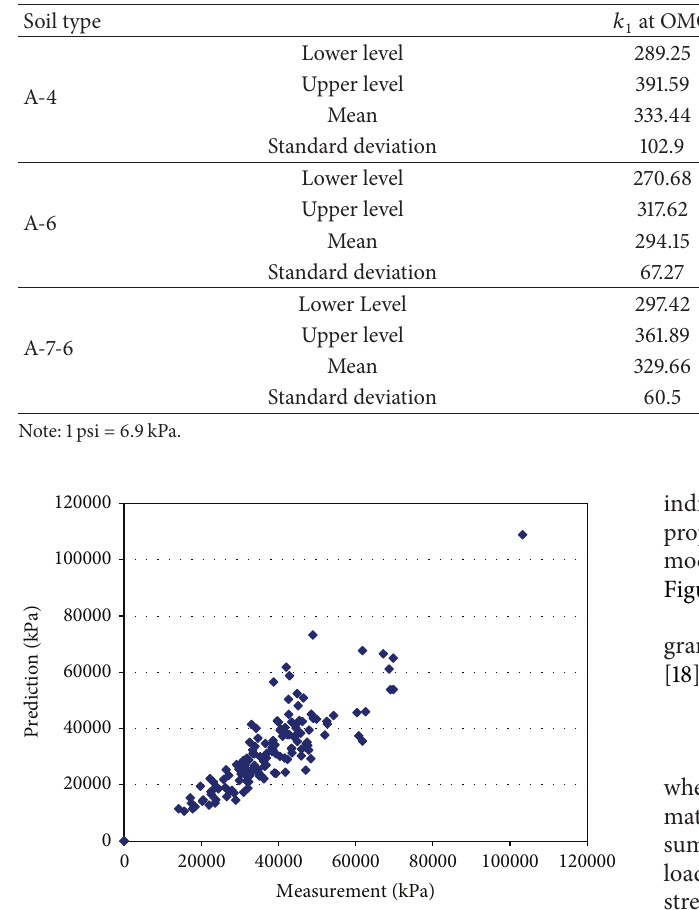
Figure 3: Measured versus predicted resilient modulus values at different confining and deviator stresses ( 𝑅 2 = 0.72